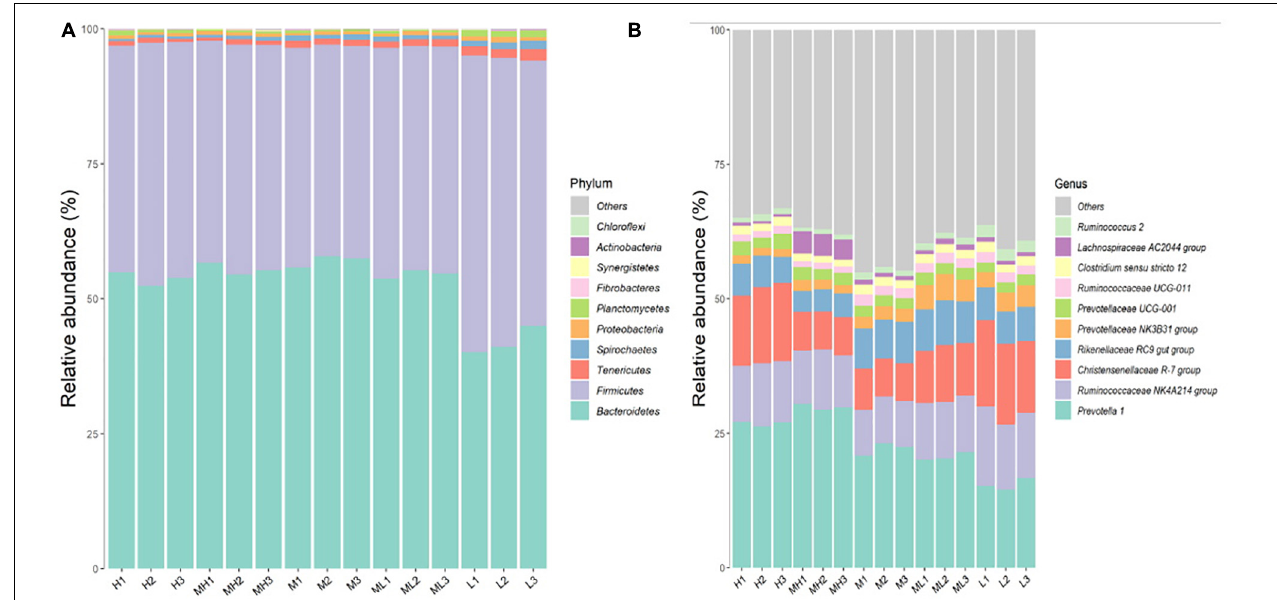
FIGURE 4 | Rumen bacterial compositions (A) at the phylum level (only the top 10 abundant phyla were presented) and (B) at the genus level (only the top 10 abundant genera were presented). H group: 33.0% peNDF 1 . 18 treatment. MH group: 29.9% peNDF 1 . 18 treatment. M group: 28.1% peNDF 1 . 18 treatment. ML group: 26.5% peNDF 1 . 18 treatment. L group: 24.8% peNDF 1 . 18